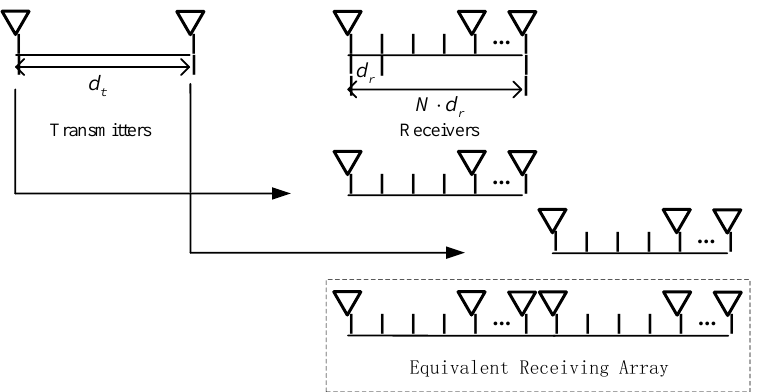
Figure 1. The structure of sparse-array Multiple Input Multiple Output (MIMO) radar.